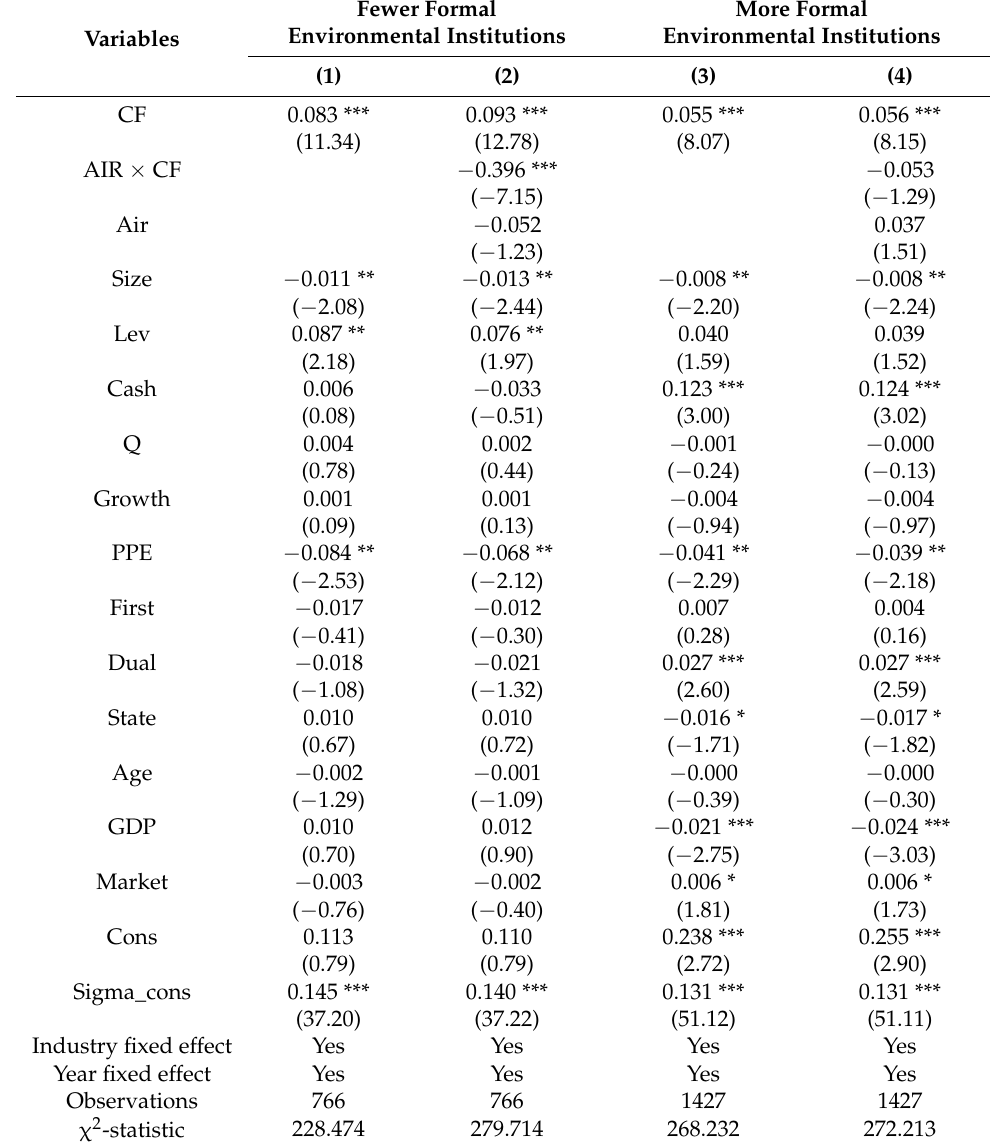
Table 8. Grouping based on local formal environmental regulations. Fewer Variables